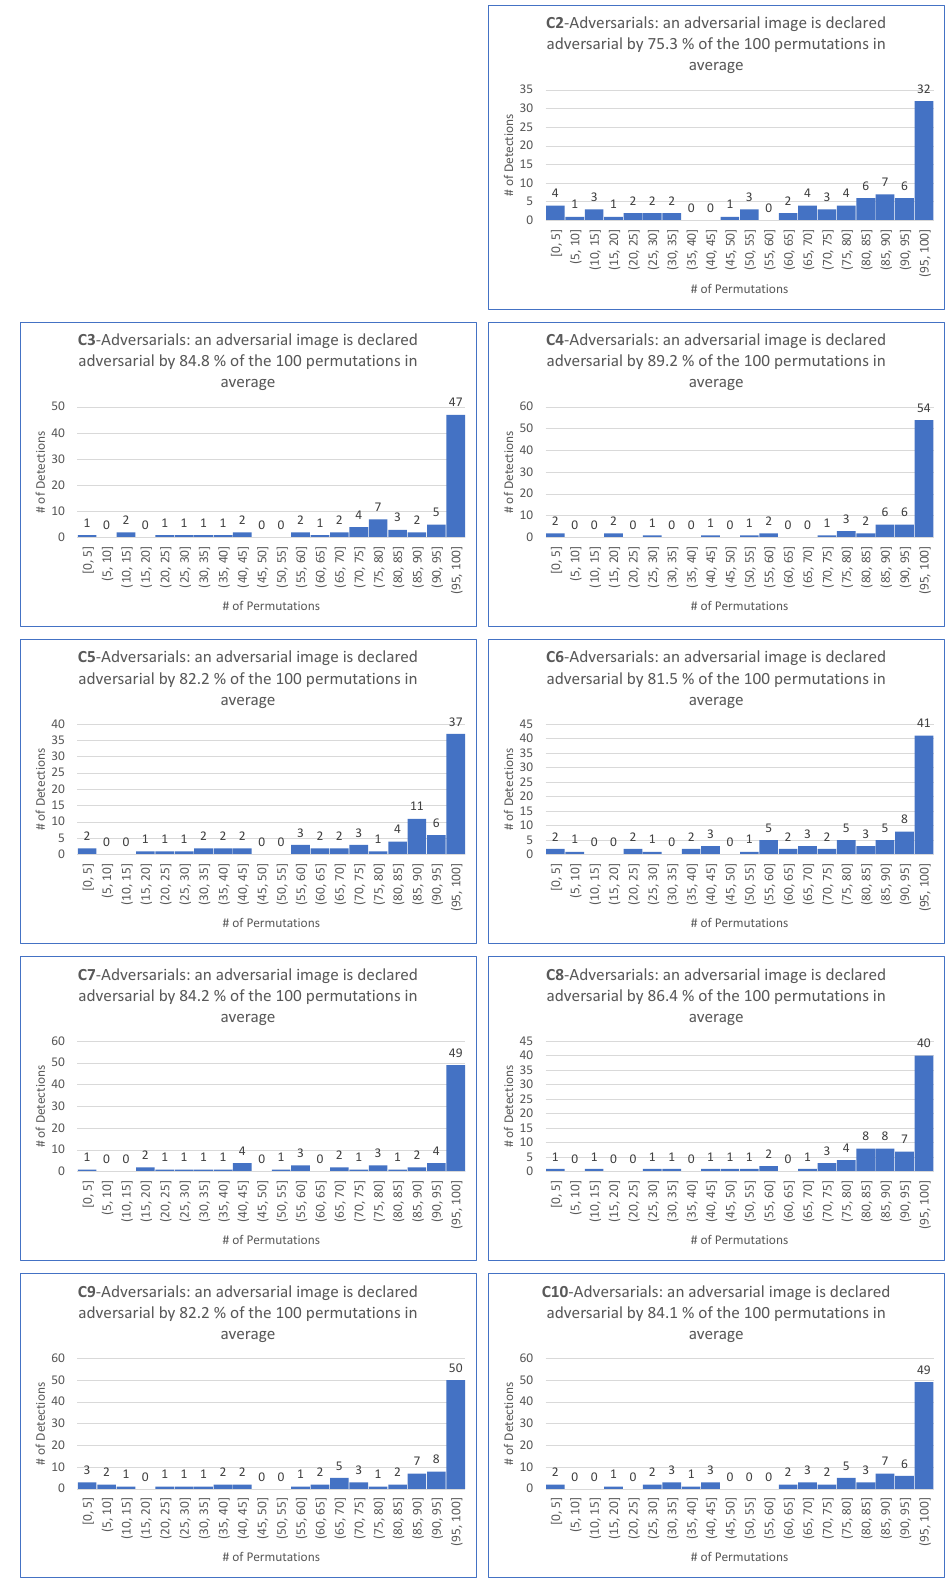
Figure A8. ShuffleDetect results for adversarial images generated by the FGSM-untargeted attack on C = C for 2 ≤ k ≤ 10 over 100